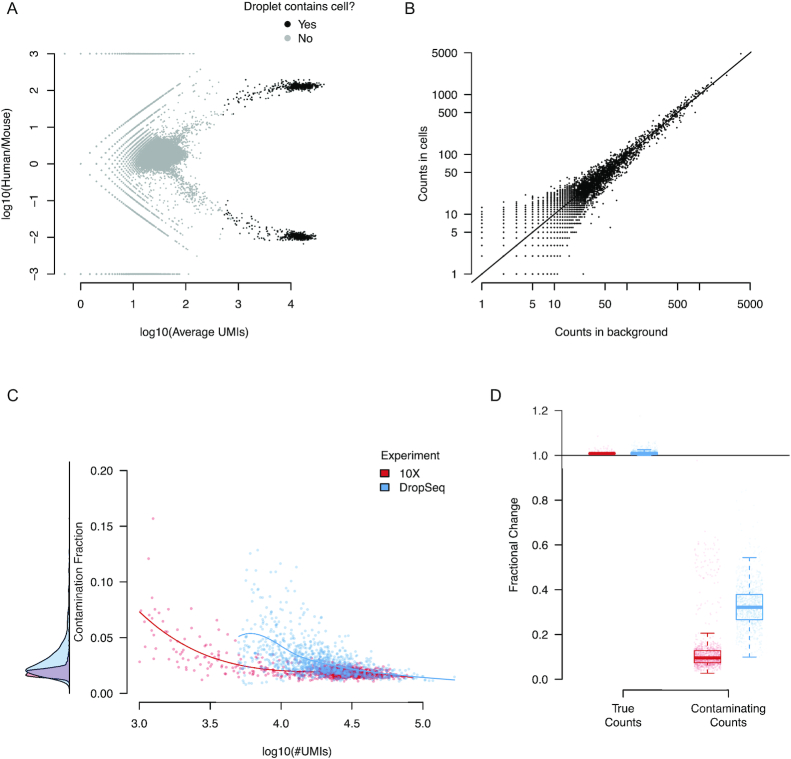
The properties of the cell-free mRNA soup as determined using species-mixing datasets. A, The log10 ratio of the number of UMIs mapping to human and mouse mRNAs for each droplet in the species-mixing dataset (10X). Droplets determined to contain cells by cellranger are marked in black. B, The correlation of the counts in the background compared to counts averaged across cells for each gene. Counts have been subsampled so that the total number of counts in the background and averaged cell population are the same. C, The estimated contamination fraction as a function of number of UMIs in each droplet in individual cells in the species-mixing dataset. Red and blue dots represent cells from the 10X/DropSeq experiments, respectively. The distribution on the left shows the marginal distribution across all cells. D, The fractional change in contaminating and genuine expression levels after applying SoupX for the 2 technologies. The distribution across cells is summarized by box plots, where the central line is the median, box boundaries are the first and third quartiles, and the whiskers extend to 1.5 times the interquartile range.